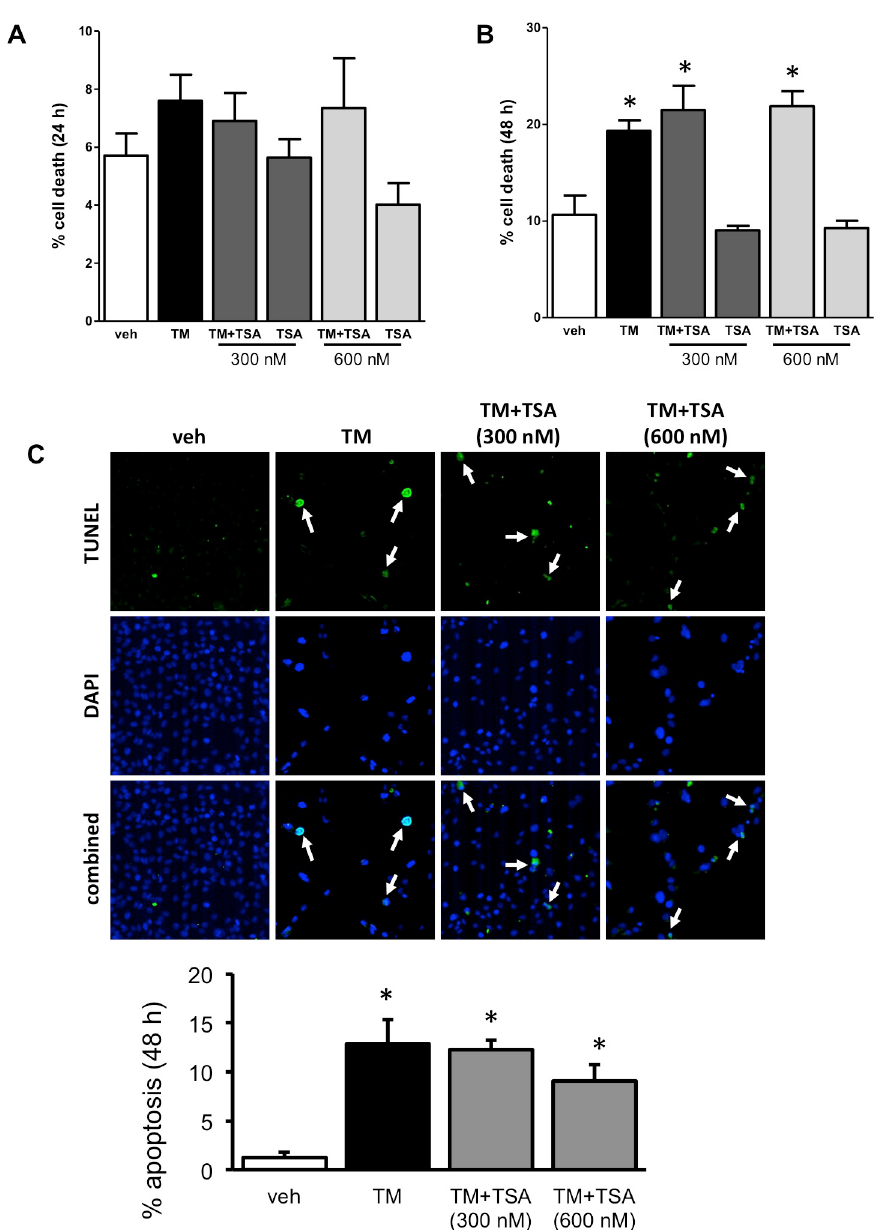
Fig 6. Human proximal tubular cells were treated with TM with TSA (300 nM or 600 nM). (A) No significant cell death was found at 24 hrs. (B) At 48 hrs, TM induced cell death, which was not prevented by co-treatment of TSA. (C) At 48 hrs, TM induced apoptosis, which was not prevented by co-treatment of TSA. � , P < 0.05 vs veh. vorinostat did not cause any change in expression to other ER stress markers (CHOP, sXBP1) or in protein aggregation in vitro . Similarly, TSA did not affect protein levels of GRP78 or CHOP induced by TM in proximal tubular cells. Further, vorinostat did not inhibit expression of GRP78 or CHOP in vivo , indicative of absent or inadequate ER stress inhibition. Studies have demonstrated both anti-apoptotic and pro-apoptotic effects of HDAC inhibi- tion. HDAC inhibitors have been shown to be protective in animal models of kidney disease.